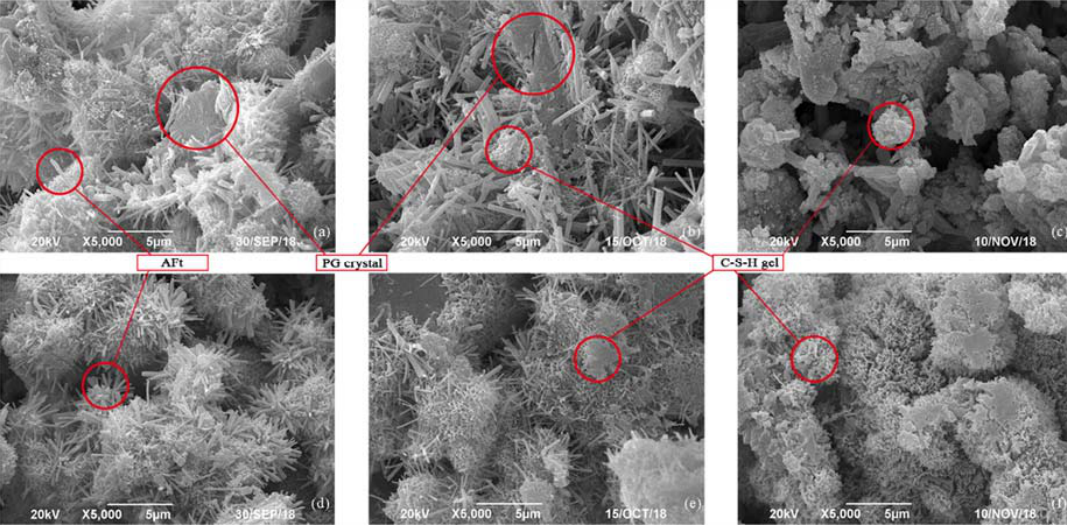
Figure 13. SEM images of OCPB samples with ( a ) 7days, ( b ) 14 days, and ( c ) 28 days curing age and TCPB samples with ( d ) 7days, ( e ) 14 days, and ( f ) 28 days curing age.